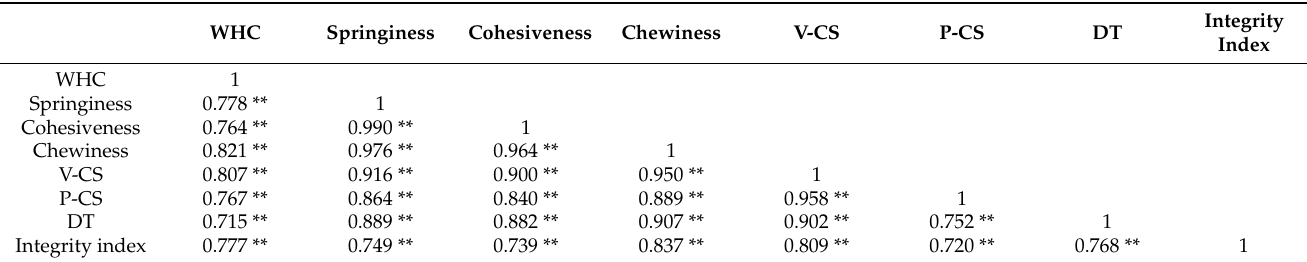
Table 4. Pearson correlation matrix of physical properties for high-moisture meat